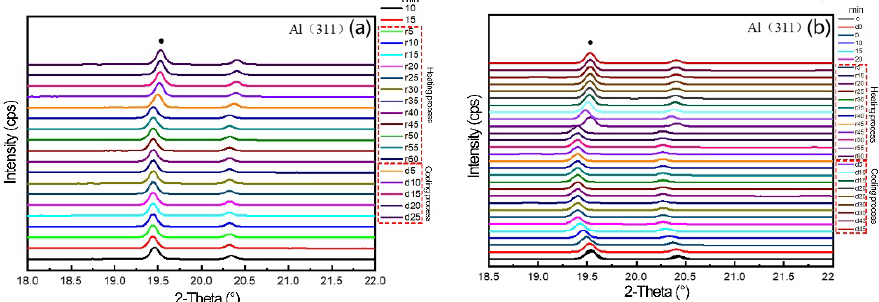
Figure 9. Diffraction pattern of temperature change after in situ loading: ( a ) 200 °C, ( b ) 280 °C.